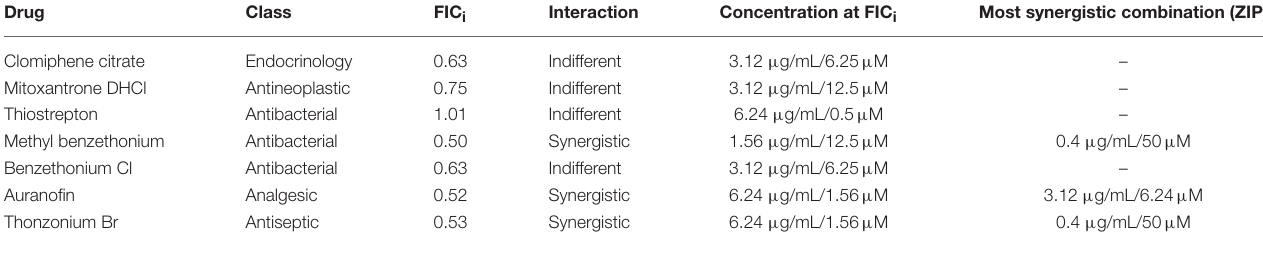
TABLE 3 | Selected Drug/Colistin combinations, FIC indexes, and corresponding classification (Colistin/Drug).